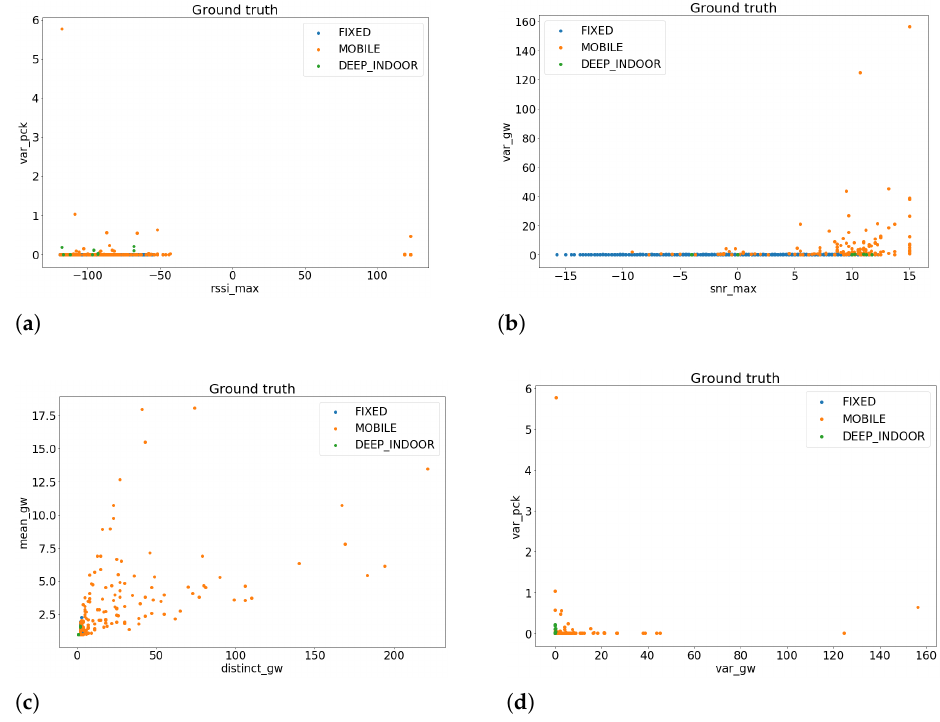
Figure 2. Plots of the worst samples’ features. ( a ) RSSI max vs. Var PCKs; see Table 1; ( b ) SNR max vs. Var GW; see Table 1; ( c ) Distinct GW vs. mean GW; see Table 1; ( d ) Var GW vs. Var PCKs; see Table